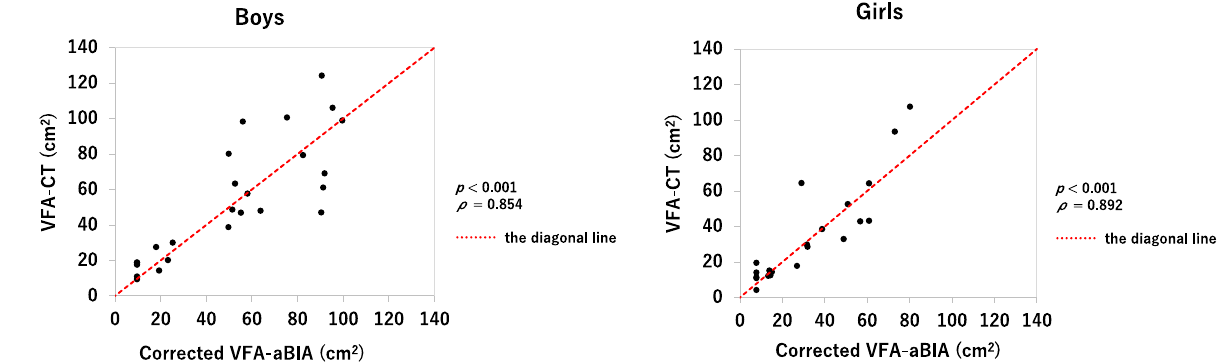
Figure 2. Correlation between VFA-aBIA and VFA-CT in boys and girls. VFA-aBIA—visceral fat area measured by abdominal bioelectrical impedance analysis using EW-FA90 (Panasonic Corpora- tion, Osaka, Japan); VFA-CT—visceral fat area measured using computed tomography. Corrected VFA-aBIA correlated significantly with VFA-CT in both boys and girls ( ρ = 0.854, p < 0.001 and ρ = 0.892, p < 0.001, respectively; Figure 3). Figure 4 shows the Bland– Altman plot of VFA-aBIA and VFA-CT. The mean ± 2 standard deviations for corrected VFA-aBIA minus VFA-CT was − 2.2 ± 38.2 (cm 2 ) in boys and − 2.4 ± 26.2 (cm 2 ) in girls, respectively, indicating that the precision in girls was better than that in boys.